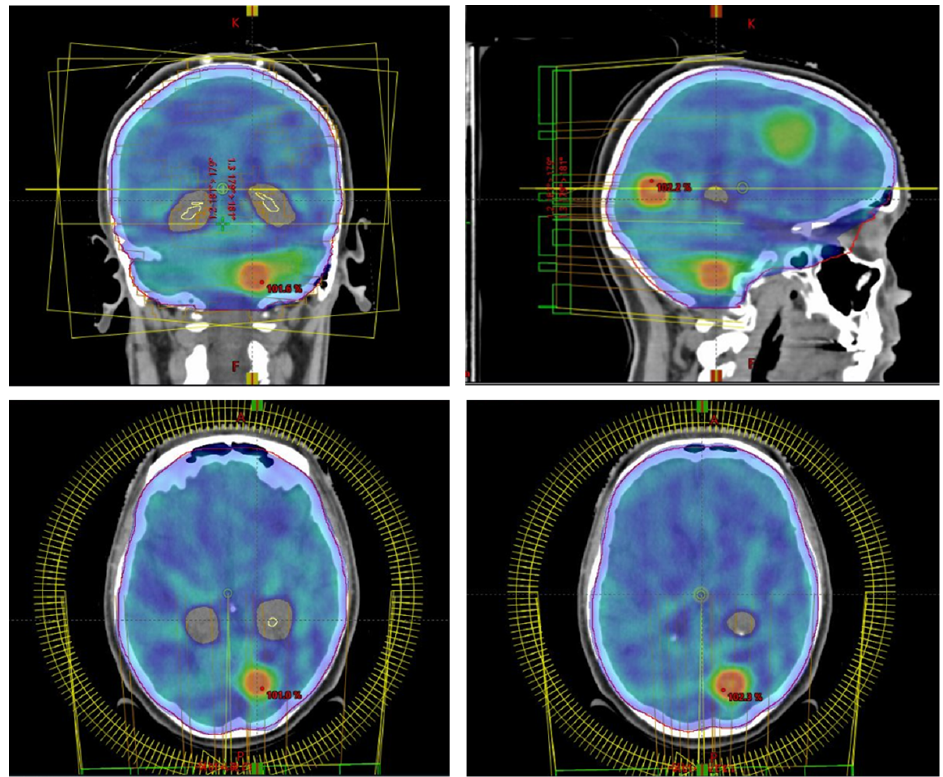
Figure 1. Example of a treatment plan of whole-brain radiotherapy plus a simultaneous integrated boost to the metastatic lesions using a hippocampus-sparing technique (Department of Radiation Oncology, University of Lübeck, Germany).